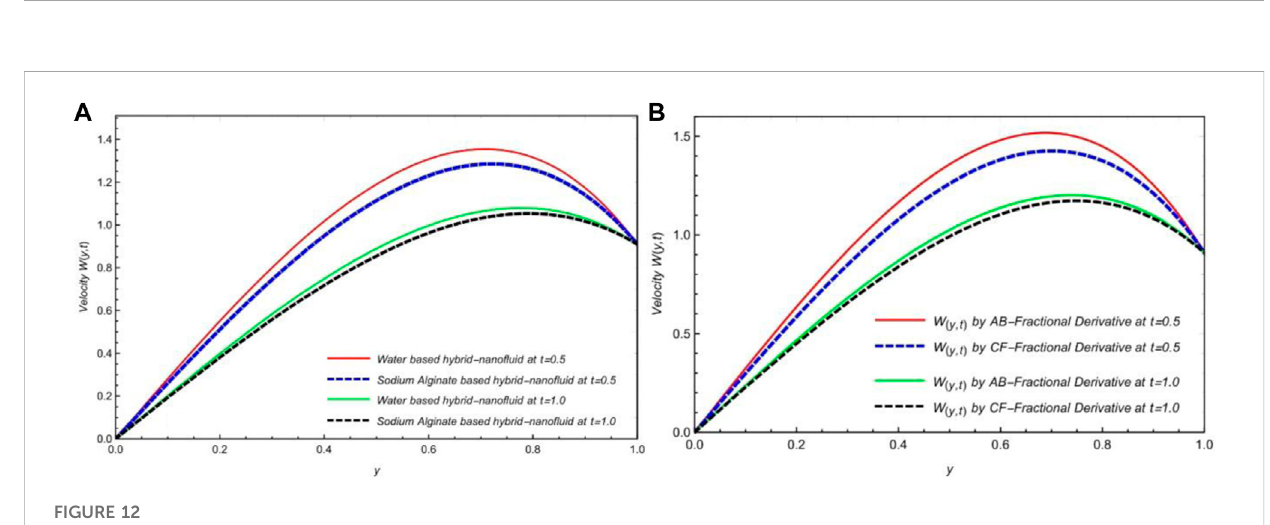
FIGURE 12 Comparison of W ( y , t ) for AB- and CF-fractional derivatives at ( A ) t (cid:2) 0 . 5 and ( B ) t (cid:2) 1 .